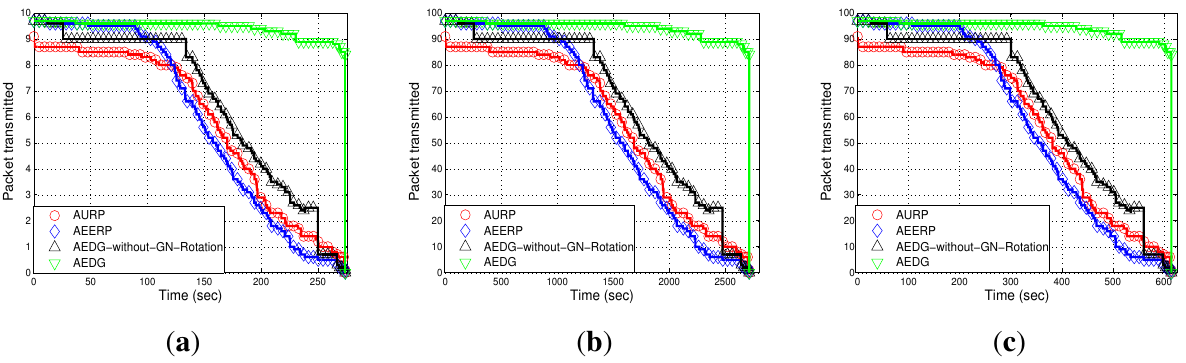
Figure 14. Packet transmission rate. ( a ) 10 nodes deployed in 100 m × 100 m; ( b ) 100 nodes deployed in 100 m × 100 m; ( c ) 100 nodes deployed in 10 km × 10 km.